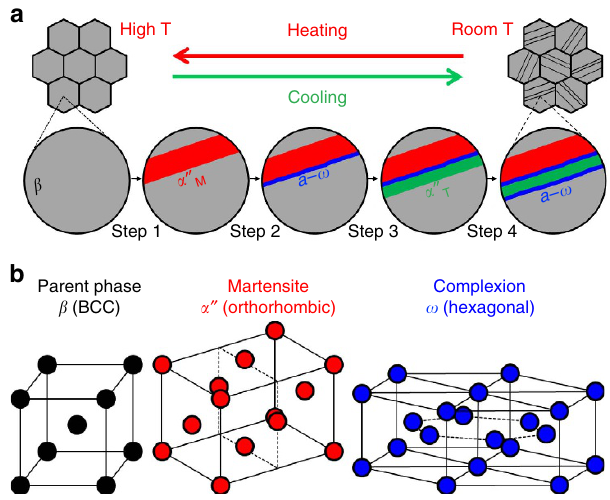
Figure 1 | Schematic illustration of the phase transformations and crystal structures of the phases involved. ( a ) Schematic illustration for complexion-mediated martensitic phase transformation in a b -Ti alloy matrix (from left to right): Step 1, formation of a 00 -matrix; Step 2, formation of first a – o planar complexion; Step 3, formation of a 00 -twin; and Step 4, formation of second a – o planar complexion. ( b ) Crystal structures of b parent phase, a 00 martensite and o